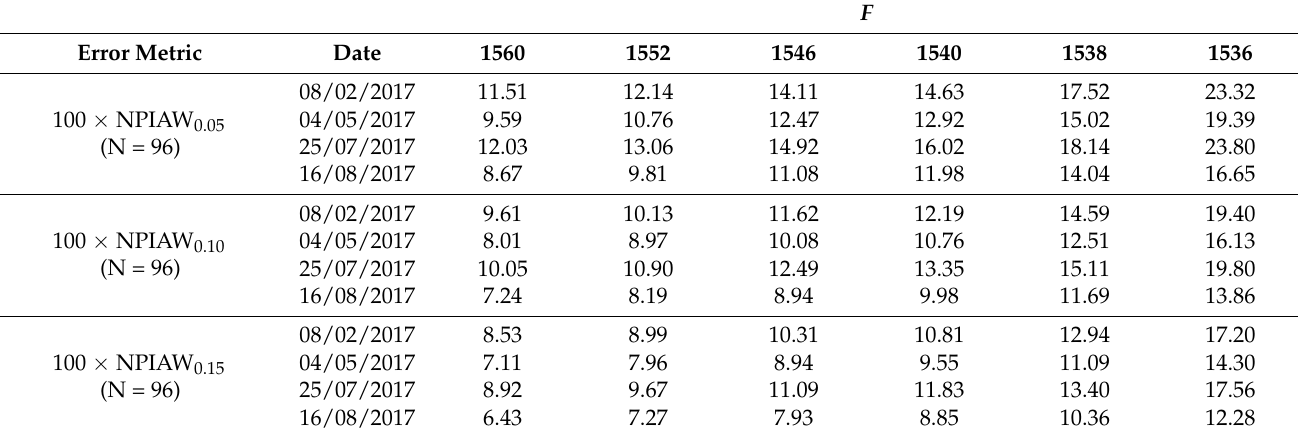
Table 10. NPIAW α results for computed scenarios ( F , α ) .